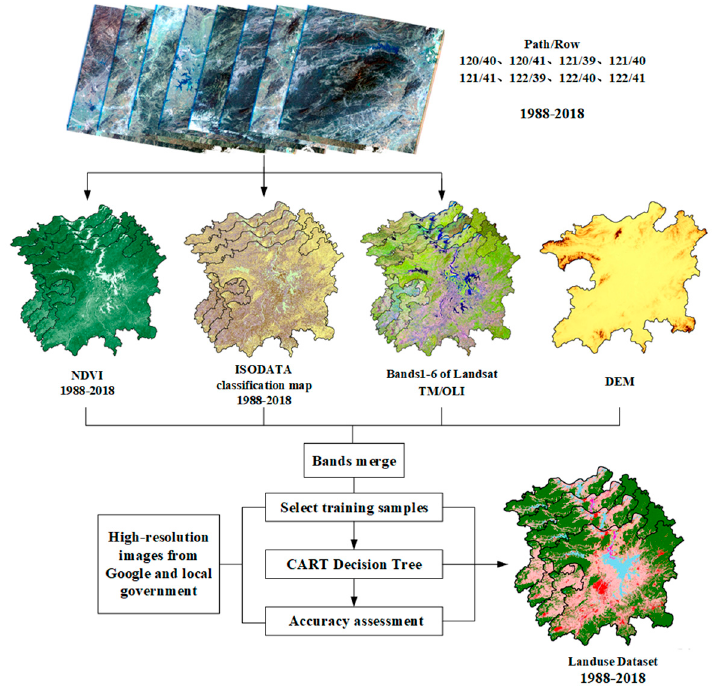
Figure 2. Land-use classification process.